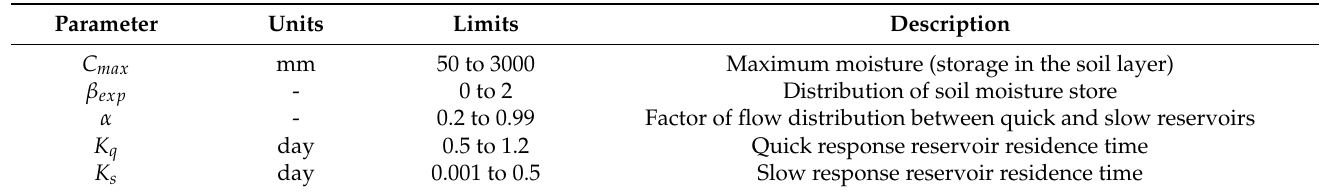
Table 2. Description of main parameters of HYMOD model.